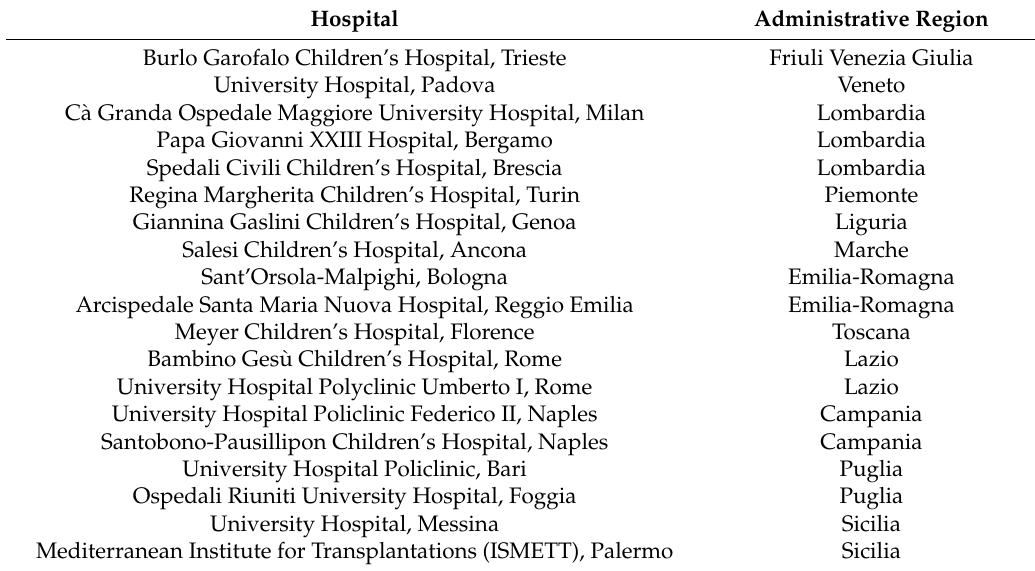
Table 1. Centers involved in the